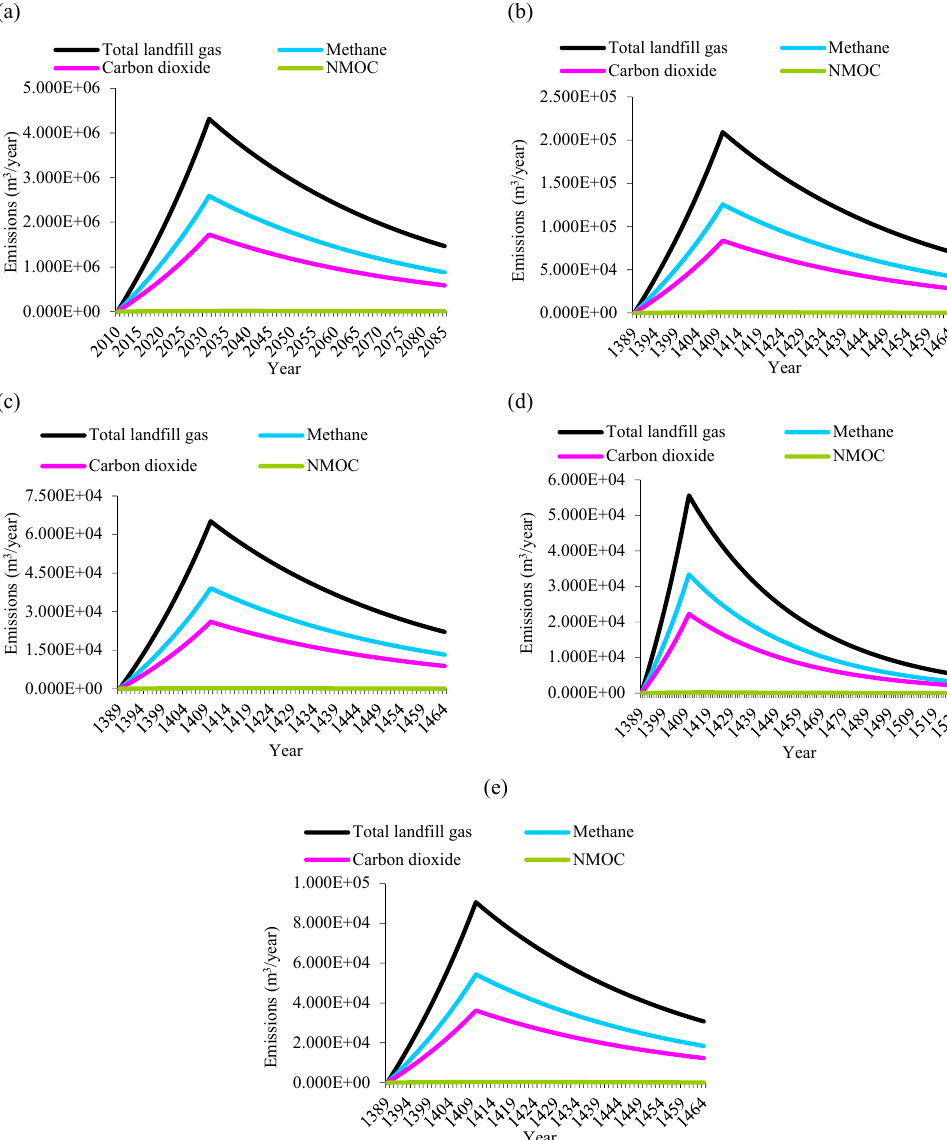
Fig. 5: Potential of gas emission from slowly degradable organic compounds in (a) Hamedan, (b) Bahar, (c) Joraghan, (d) Marianaj and (e) Lalejin